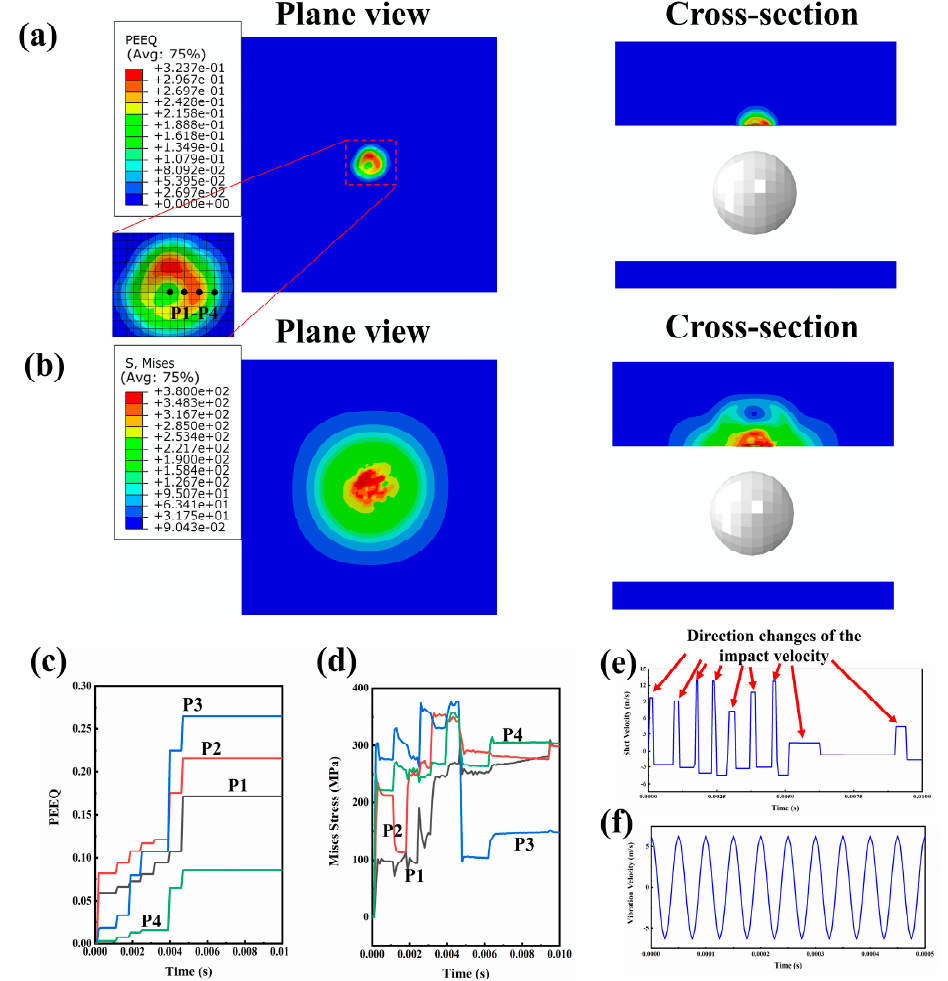
Figure 4. Simulation results of a shot during the ultrasonic shot peening process: ( a ) Plane view of the simulation results of the target surface with a duration of 1 × 10 − 2 s; ( b ) cross-sectional view of the simulation results of the target surface with a duration of 1 × 10 − 2 s. ( c ) simulated PEEQ of the materials during the ultrasonic shot peening process; ( d ) simulated von Mises stress of the materials during the ultrasonic shot peening process; ( e ) simulated velocity of the shot; ( f ) simulated velocity of the vibrating